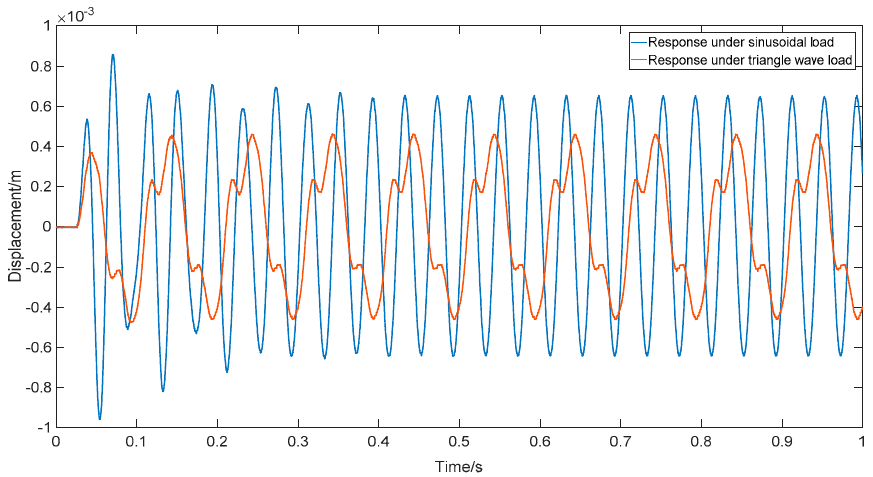
Figure 30. The displacement response.